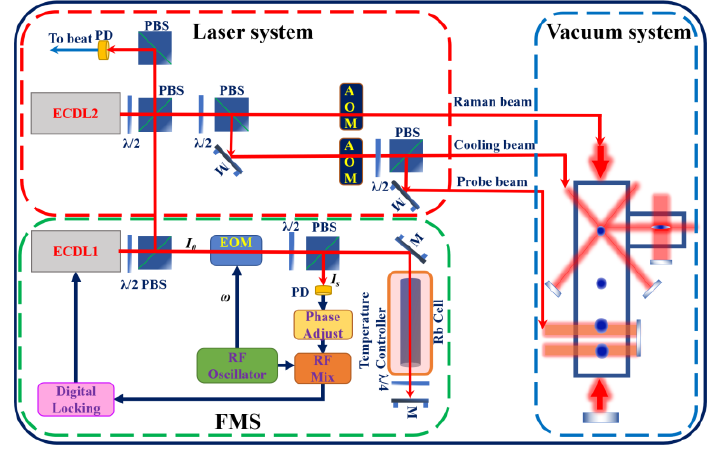
Figure 1. Scheme of frequency modulation spectroscopy (FMS). ECDL is the external-cavity diode laser, EOM is the electro-optic modulator, PBS is the polarizing beam splitter, PD is the photo diode, λ/4 is the quarter-wave plate, M is the mirror.